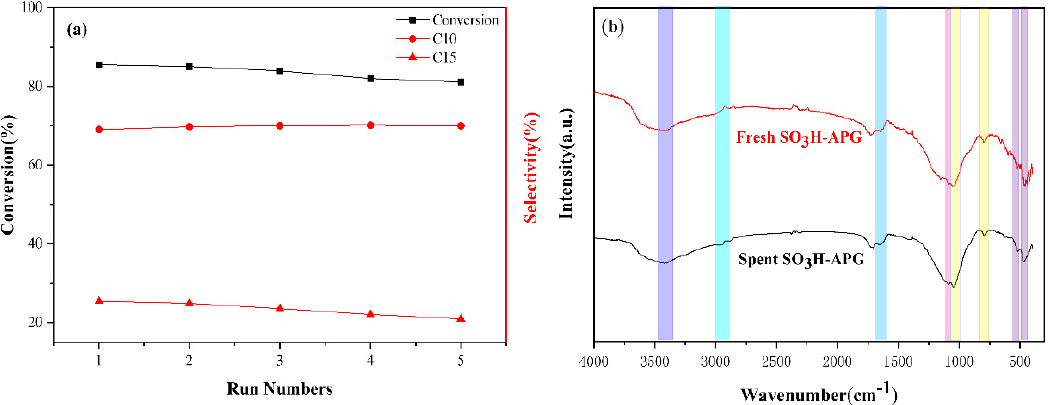
Figure 7. Recycling performance of SO 3 H-APG catalyst. ( a ) Catalytic performance. ( b ) FT-IR spectra of fresh and 5-run spent catalysts.